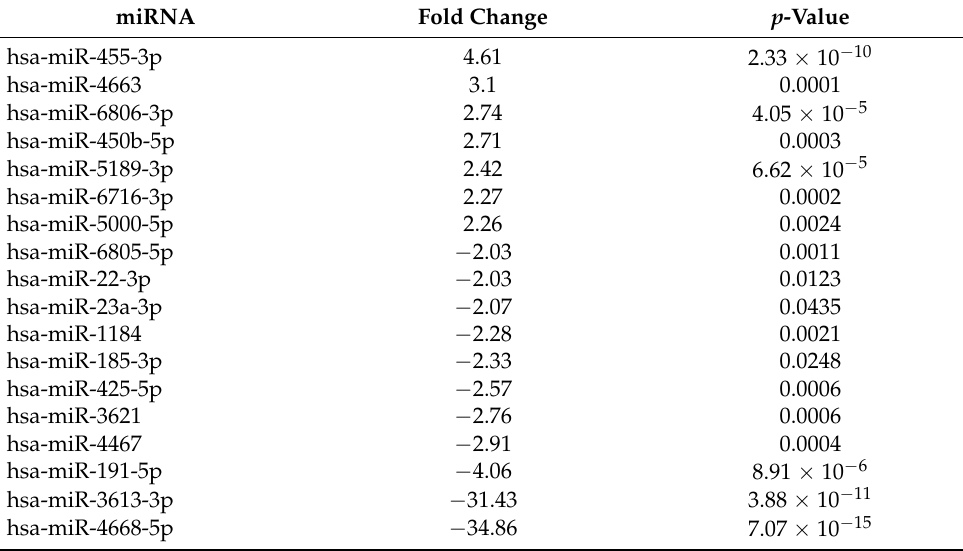
Figure 2. ( A ) Principal component analysis, ( B ) unsupervised hierarchical clustering analysis, ( C ) pathway analysis using serum miRNAs in suspected ocular sarcoidosis versus healthy controls. HS: healthy subjects, SS: patients with suspected ocular sarcoidosis. Table 3. Differential expression of serum miRNAs in suspected ocular sarcoidosis versus healthy controls.